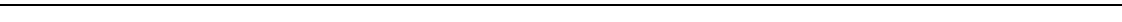
Figure 1 | PX-RICS (cid:2) / (cid:2) mice exhibit behavioural features similar to the core triad of impairments in ASD. ( a , b ) Three-chamber social interaction test. The time spent in close interaction with each wired cage in each session is shown ( a ). E, empty; FS, familiar stranger; NS, novel stranger; S; stranger. Voluntary sociability and social preference are represented as a preference index, the ratio between time spent near the left and right wired cages in each session ( b ; see Methods). The negative value in PX-RICS (cid:2) / (cid:2) mice in the familiar–stranger session (novel/familiar) shows their preference for a familiar stranger mouse. ( c – f ) Dyadic social interaction test. PX-RICS (cid:2) / (cid:2) mice spent less time in social activities ( c – e ) and showed a markedly lower success rate of social interaction in response to stimulator-initiated approach ( f ). ( g ) Social dominance tube test. PX-RICS (cid:2) / (cid:2) mice have a markedly lower winning rate. ( h ) The number of USVs of PX-RICS þ / þ mice peaked on PND7 and decreased gradually, whereas that of PX-RICS (cid:2) / (cid:2) mice were significantly lower, without a peak of calls. ( i – k ) PX-RICS (cid:2) / (cid:2) mice spent more time performing repetitive behaviours such as self-grooming ( i ) and digging ( j , k ). ( l , m ) Water T-maze test. In the reversal learning session, PX-RICS (cid:2) / (cid:2) mice showed a lower number of successful (correct arm choice) trials ( l ) and required more time to reach an escape platform ( m ), which markedly contrasts with their normal learning ability in the acquisition session. Data are represented as means ± s.e.m. NS, not significant; * P o 0.05; ** P o 0.01; *** P o 0.001. One-way analysis of variance (ANOVA) with Tukey’s post hoc test ( a – e , h – k ), two-way ANOVA with Bonferroni’s post hoc test ( f , l , m ) and two-tailed binomial test ( g